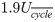
Flow structure at: (a) systole (0.25 ≲ t/T ≲ 0.31); (b) cycle-averaged state (0 ≤ t/T ≤ 1); (c) steady state with the Reynolds number at the systolic peak, Re = 651; (d) steady state at Re = 1000.The velocity iso-surface thresholds are 1.9Ucycle¯, 1.1Ucycle¯, 1.9Ucycle¯, and 2.9Ucycle¯, respectively.